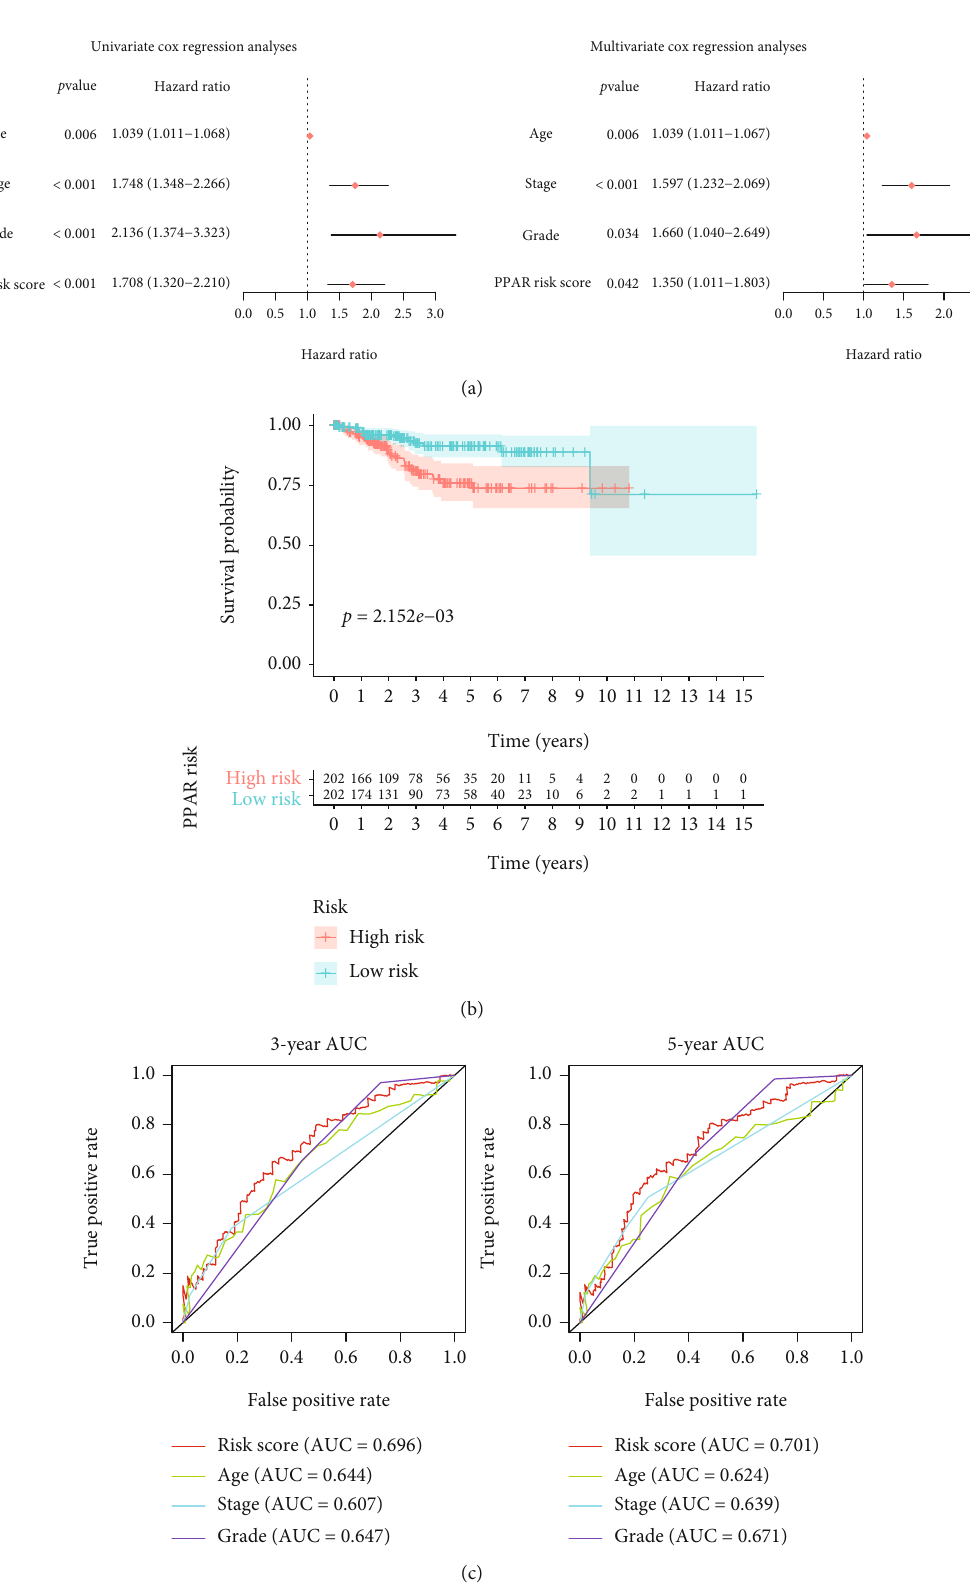
Figure 7: Veri fi cation of the PPAR risk score ’ s independent prognostic value. (a) Forest plots of univariate and multivariate Cox regression analysis involving the PPAR risk score and clinical variables. (b) Overall survival Kaplan-Meier curves for patients in the high-risk and low- risk groups. (c) Curves of time-dependent receiver operating characteristic at one, three, and fi ve years. AUC: area under